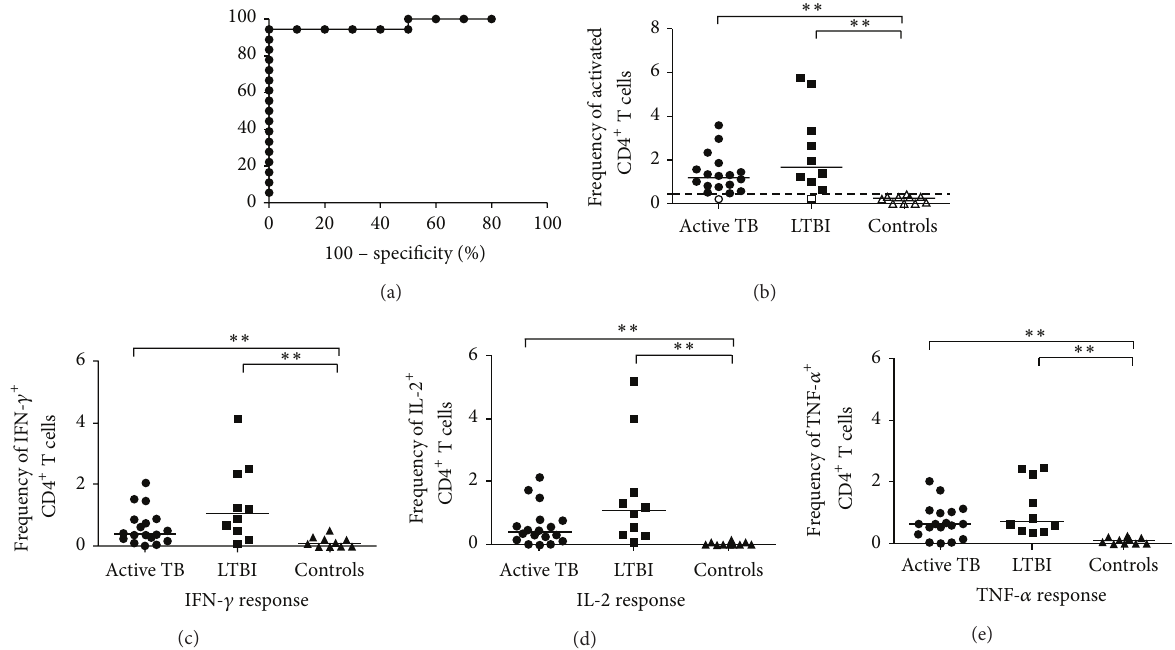
Figure 2: Analysis of cytokine production by CD4 + cells at the single-cell level. (a) ROC curve (plotting sensitivity versus 1 − specificity) to discriminate infected (active TB and LTBI) from uninfected patients. The area under curve (AUC) was 0.9722. (b) Analysis of activated M. tuberculosis -specific CD4 + T cells producing any of the 3 cytokines (IFN- 𝛾 , IL-2, or TNF- 𝛼 ), using a cut-off to score responses as either positive or negative. The subjects were considered as positive (black) whether the frequency of CD4 + T cells was > 0.45% and negative (white) when the frequency was < 0.45%. Horizontal bars represent the median values and horizontal dashed line indicates the cut-off of 0.45%. ((c), (d), and (e)) Frequency of “total IFN- 𝛾 + ,” “total IL-2 + ,” and “total TNF- 𝛼 + ” Mtb -specific CD4 + T cells in active TB patients ( 𝑛 = 18 ), in LTBI patients ( 𝑛 = 10 ), and in healthy controls ( 𝑛 = 10 ) is shown. Horizontal bars represent the median values. Statistical analysis was performed using Kruskal-Wallis ANOVA with Dunn’s posttest comparison and significant differences are indicated by asterisks ( ∗∗ 𝑃 < 0.01 ).